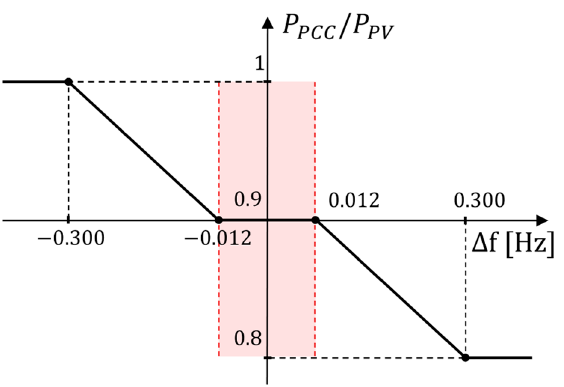
Figure 3. PV facility droop characteristic for PFR in Puerto Rico